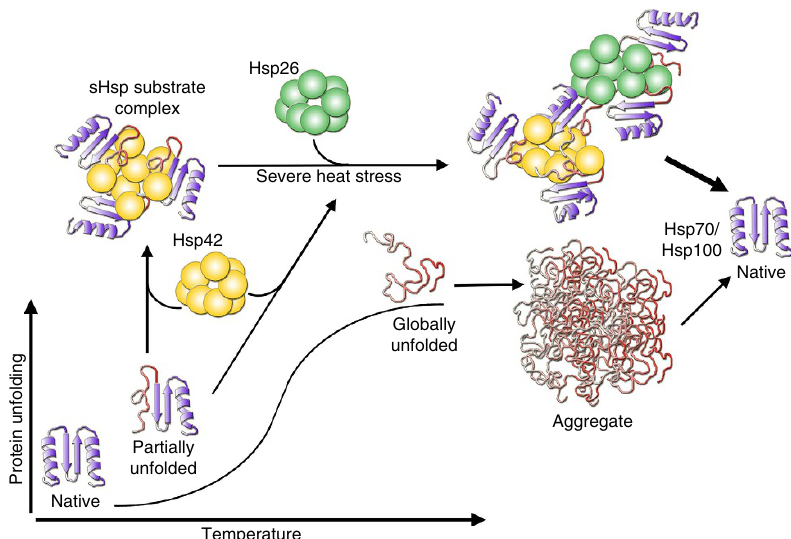
Figure 7 | Cellular activities of yeast Hsp26 and Hsp42. During initial protein unfolding Hsp42 sequesters potentially harmful species within sHsp/ substrate complexes, thereby triggering the formation of microscopic visible CytoQs in vivo . On severe heat stress, temperature-activatable Hsp26 coaggregates, resulting in more efficient dissolution of CytoQs within cells. Both sHsps sequester proteins early during misfolding and aggregation. They preserve a native-like structure of bound substrates and increase the distance between non-native protein molecules, suppressing the formation of tight, large aggregates. These features contribute to facilitated chaperone-mediated